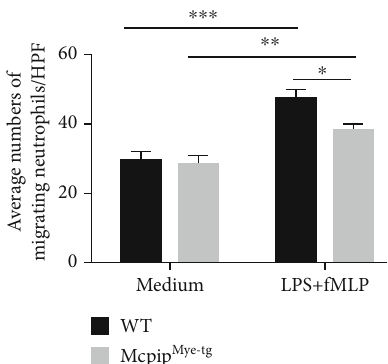
Figure 9: Overexpression of MCPIP-1 blocks the migration of neutrophils. Neutrophils ( 5 × 10 6 ) were isolated from the bone marrow of Mcpip Mye-tg ( n = 6 ) and WT ( n = 6 ) mice and measured with a 5 μ m Transwell plate under attraction with fMLP (50 nM) in the presence of LPS (100ng/mL) for 3 hours. The histogram represents the number of migrating neutrophils per high-power fi eld (HPF). ∗∗ P < 0 : 01 and ∗∗∗ P < 0 : 001